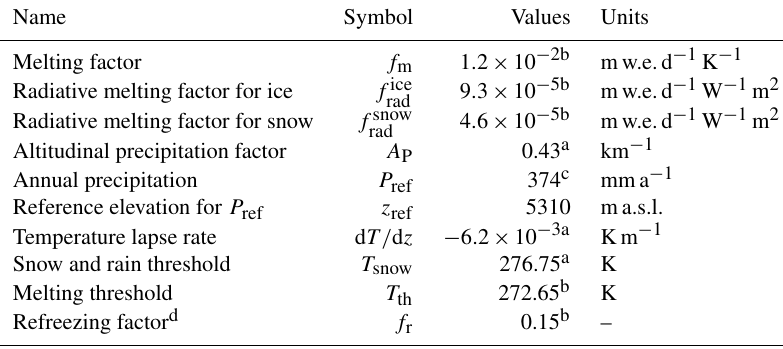
Figure 4. Modelled mass balance using ERA-Interim reanalysis data. (a) Surface mass balance at equilibrium. Black dots are stake locations from Gurung et al. (2016). (b) Mean surface mass balance during the period 1980–2016. (c) Corrected ERA-Interim annual temperature (d) Modelled annual surface mass balance compared to geodetic data (Fujita and Nuimura, 2011). (e) Modelled surface mass balance as a function of elevation at equilibrium (black line), in 2012 (red line) and 2013 (green line). Dots are stake measurements for the years 2012 and 2013 (Gurung et al., 2016). Table 2. Parameters of the surface mass balance